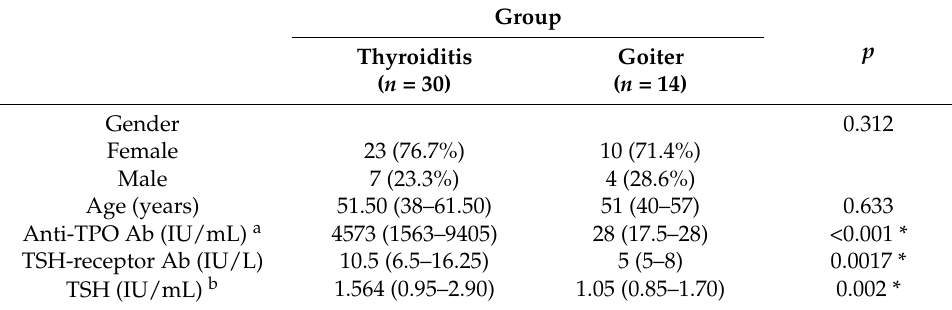
Table 1. Clinicopathological characteristics of